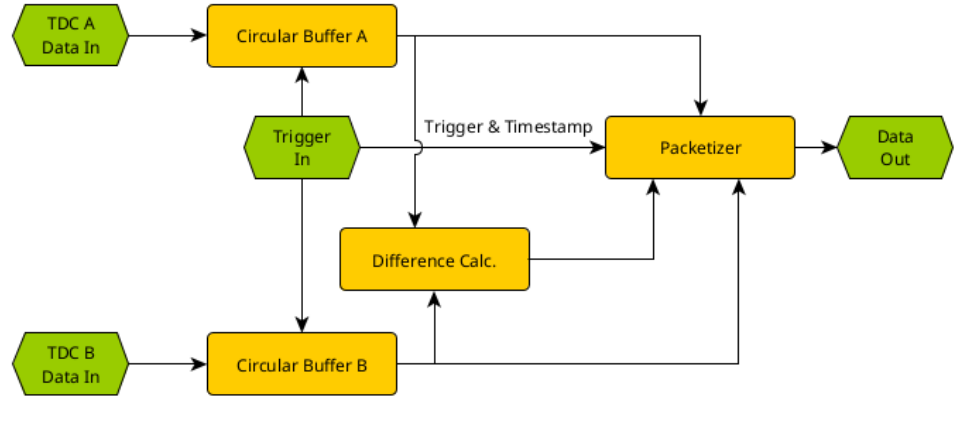
Figure 36. TDC data flow.